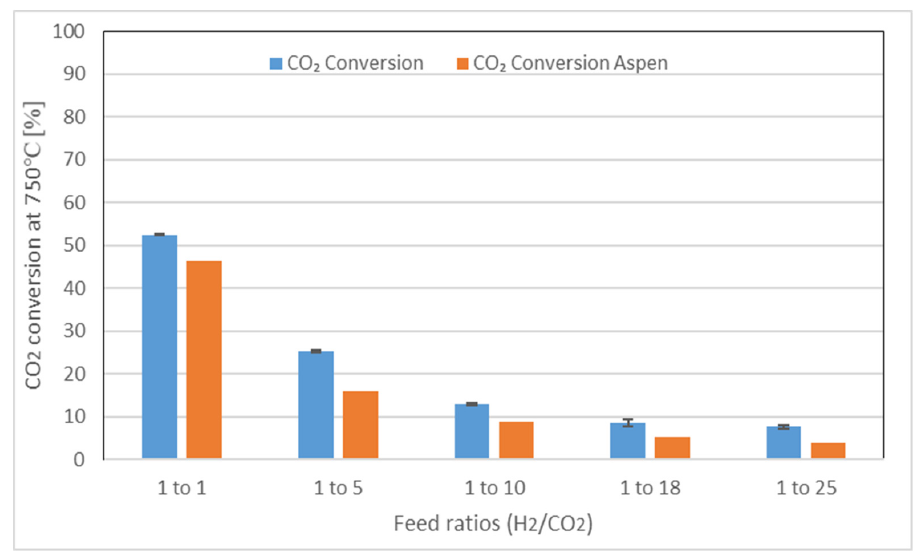
Figure 4. Catalyst activity measured as CO 2 conversion at 750 °C at different feed ratios (H 2 :CO 2 ). Investigation of condensation was carried out using the Mollier diagram before analysis due to the challenge of calculating the yield for H 2 O that might occur during the RWGS process. The results of the yields obtained for CO and H 2 O were 51% and 39%, respectively. H 2 O content obtained from the experiment was 0.018 kg/kg compared to the estimate from the Mollier diagram which was 0.015 kg/kg. Results from the calculation was used to compensate the yield of H 2 O. Table 2 shows the volume of gases at different ratios. Table 2. Volumes of gases of different feeds ratios H 2 /CO 2 for 10 wt%Ni 2 wt%Pd 0.1 wt%Ir/CeZrO 2 catalyst at 750 °C and 1 bar pressure.